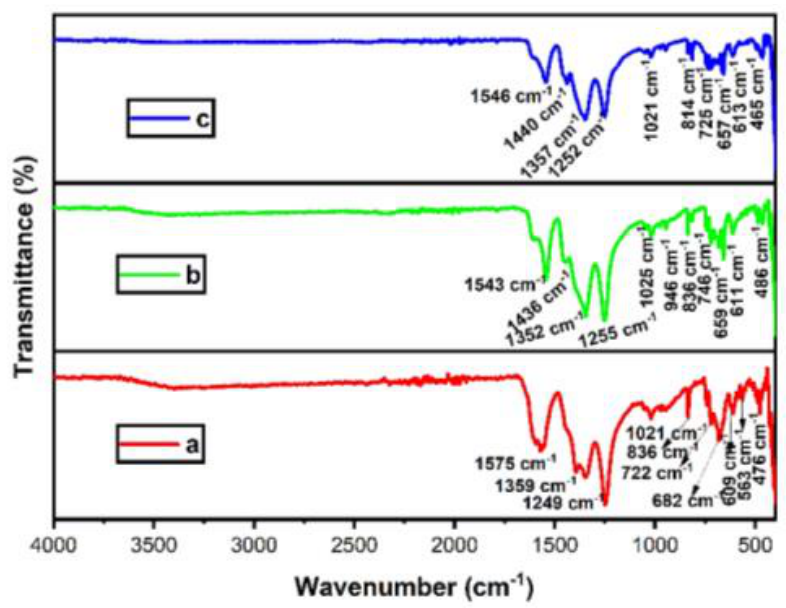
Figure 3- FTIR spectrum of Sr (0.01 (a), 0.05 (b), and 0.1 (c))-doped ZnSe nanoparticles. Figure 3. FTIR spectrum of Sr (0.01 ( a ), 0.05 ( b ), and 0.1 ( c ))-doped ZnSe nanoparticles.